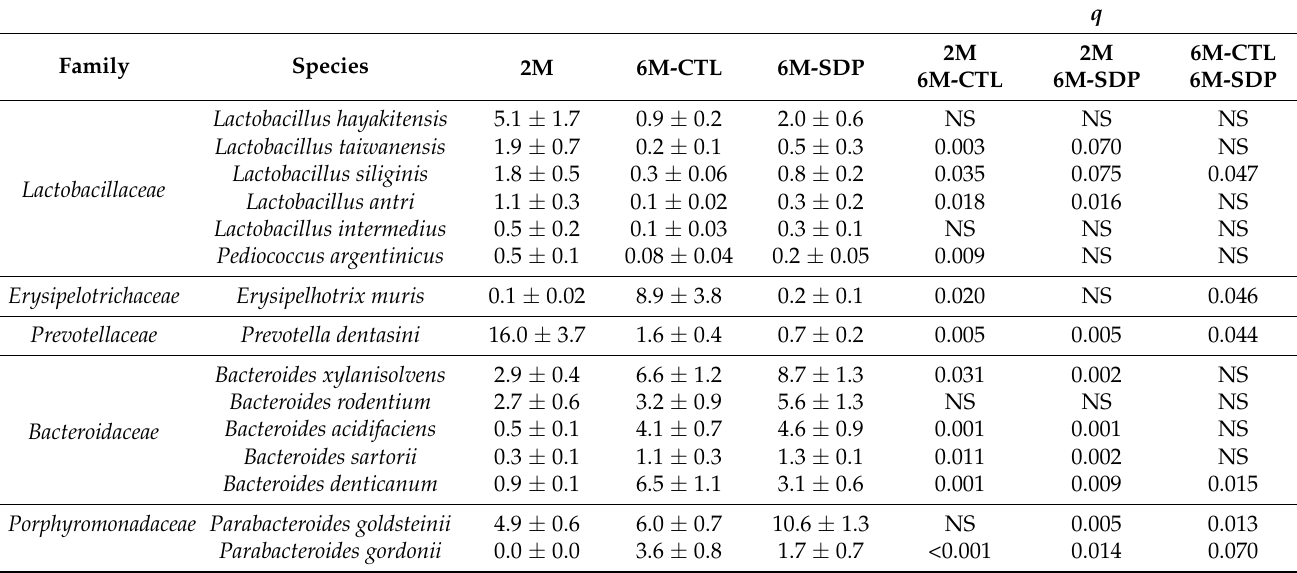
Table 2. Effects of age and SDP on bacterial composition at species